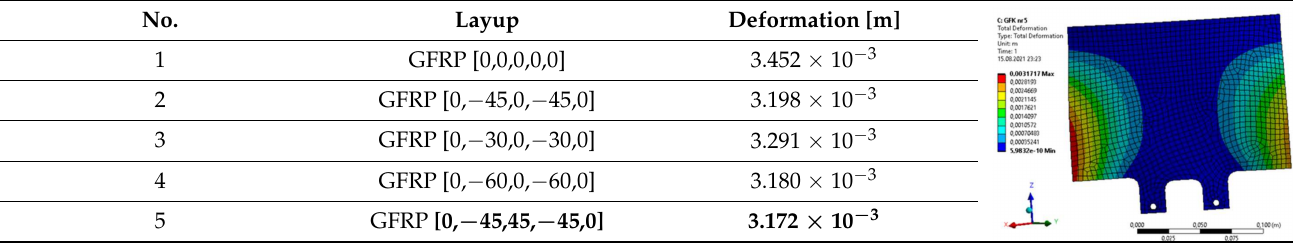
Figure 12. Final composite blade concepts: ( a ) GFK; ( b ) CFK. Table 4. FE simulation: GFK variant.